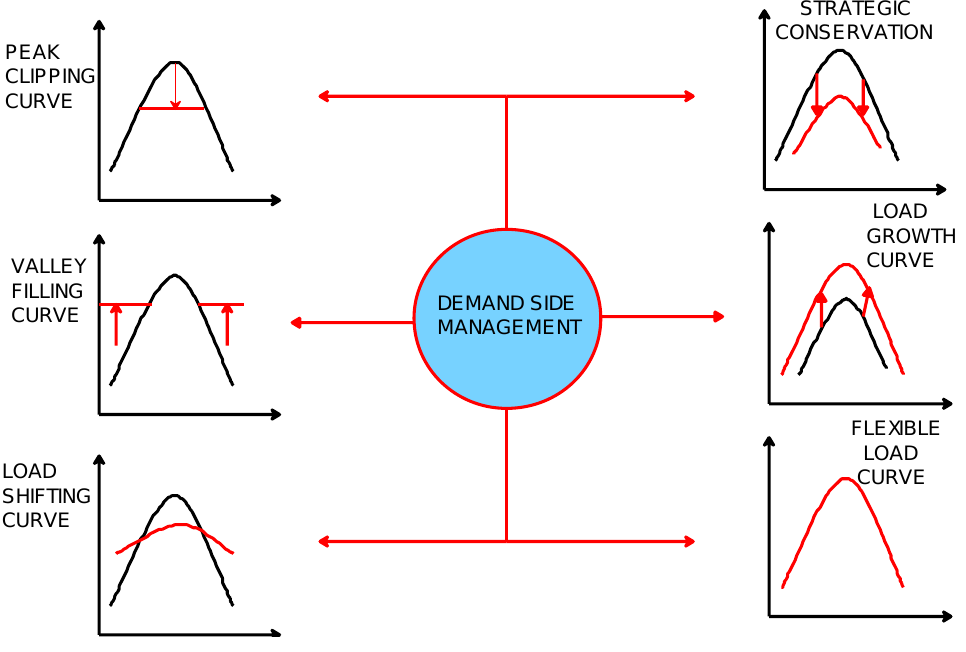
Figure 4. DSM techniques.